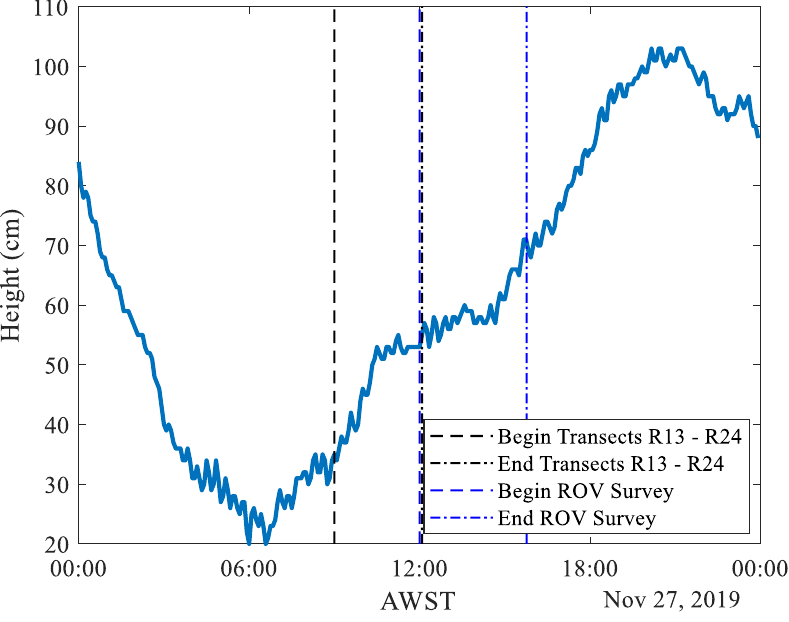
Figure 5. Water height at tide station Fishing Boat Harbour covering the date surveys took place. Height is given in reference to the low-waterline mean (LWM Fremantle 1949); beginning and end of the surveys are indicated; data provided by [54].